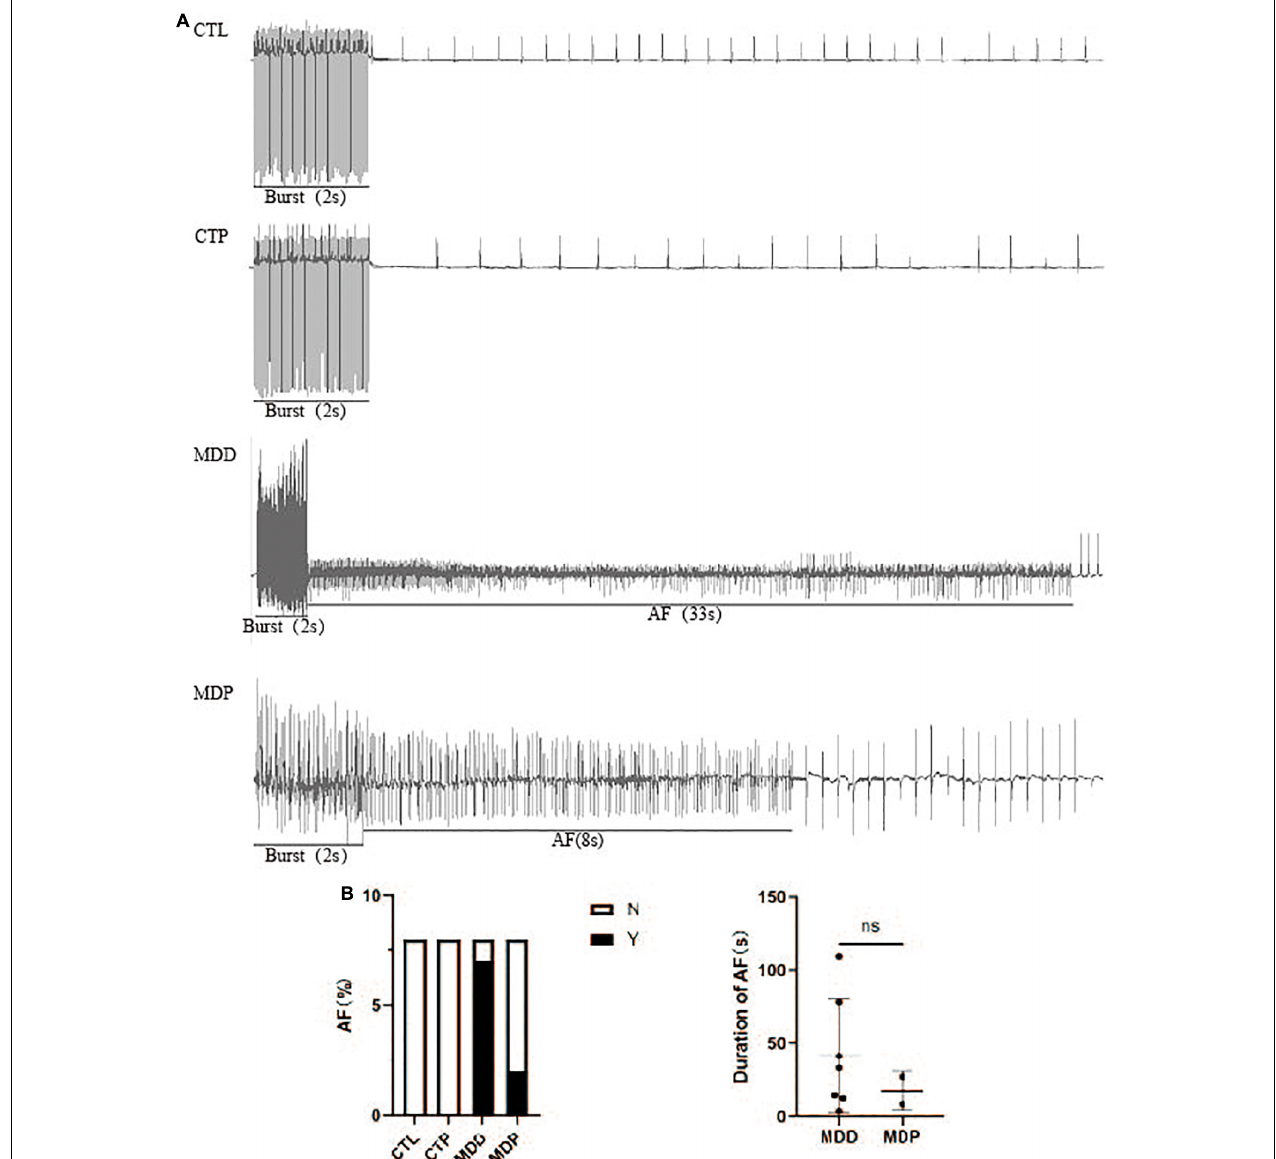
FIGURE 5 | AF susceptibility. (A) Typical recordings of AF. (B) Inducibility and duration of AFs. n = 8 per group. ns, no